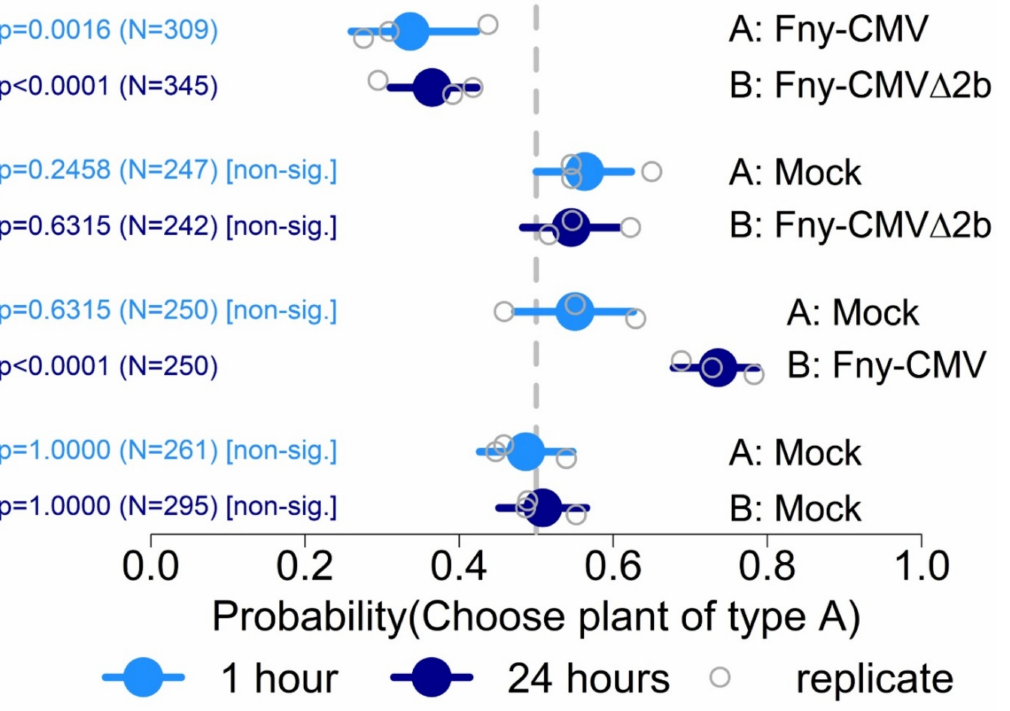
Figure 7. Summary of Myzus persicae settlement assays on tomato plants infected with Fny-CMV ∆ 2b versus plants infected with wild-type Fny-CMV or mock-inoculated plants at 21 days post-inoculation. Aphids were allowed to choose between settlement on two plants (plant A or B in various plant treatment combinations as indicated). The x -axis shows the range of the 95% credible interval of the probability of settlement of aphids ( Myzus persicae or Macrosiphum euphorbiae ) on infected plants at 1 and 24 h after aphid release, with values for each independent experiment (replicate). The total number of aphids (N) investigated for each comparison is indicated and statistical significance or non-significance was determined using binomial tests. The vertical grey dotted line indicates a probability of 0.5 of settlement on infected versus mock-inoculated plants, i.e., no